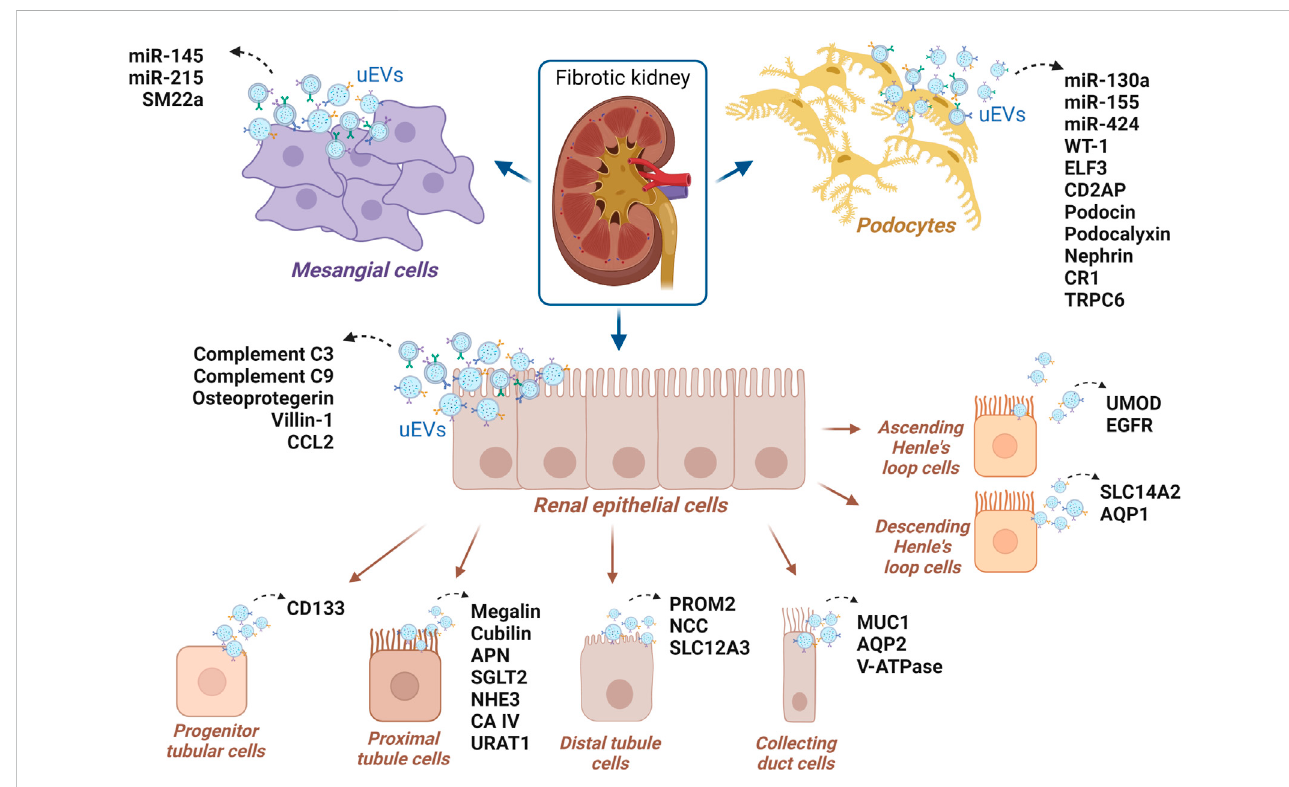
uEVs proteins and uEVs miRNAs suggested as potential markers of CKD, for which the renal cell origin has been reported in the